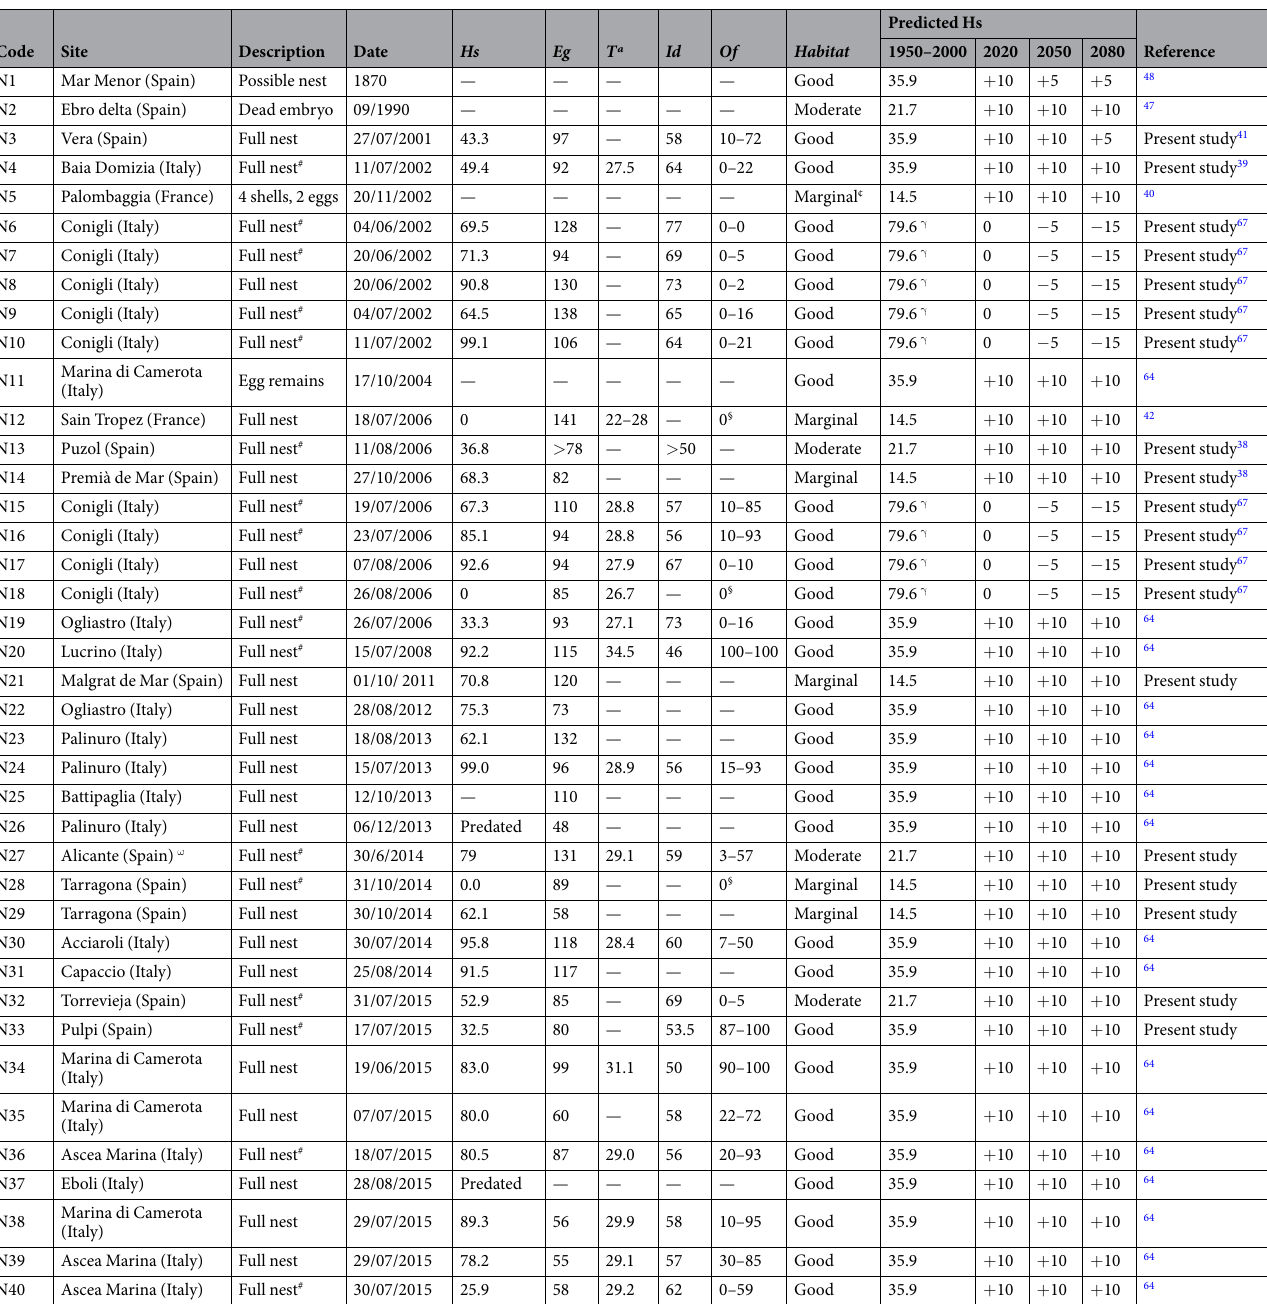
Table 1. Evidence of sporadic nests recorded in the western and central Mediterranean. Review of the evidence of sporadic nesting of the loggerhead turtle in the western and central Mediterranean and summary of the data collected in each report. Hs : hatchling success (%); Eg : number of eggs reported; Tª : mean temperature reported, Id : incubation duration (days); Of : minimum and maximum estimated percentage of female offspring using Id and four different models 73,100–102 with the corresponding corrections when needed 103 ; Habitat : habitat suitability as predicted in the literature 63 and classified in quartiles as Excellent , Good , Moderate and Marginal ; Predicted Hs : present and future Hatchling succes as predicted in the literature 77 , future values are expressed as the expected percentage of variation related to current values. (#) Nest relocated or incubated; ( ω ) Nest laid at San Juan, (Alicante) and relocated to a protected beach ~200 km north (Valencia), in the same place as nest ( N13 ) (Fig. 1); (§) All the eggs died; (¢) No habitat modelling available for this area so the value of the closest modelled area is reported; ( γ ) No modelling data on hatchling success specifically reported for Lampedusa Island, so predictions for this site may not be